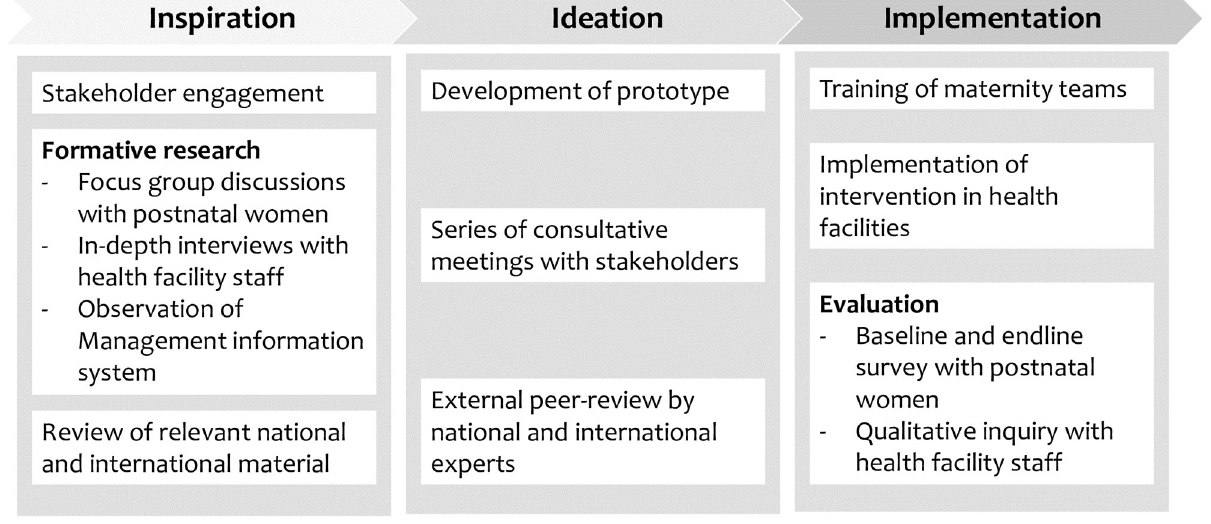
Fig 3. Stages of SDMC intervention development, implementation and feasibility